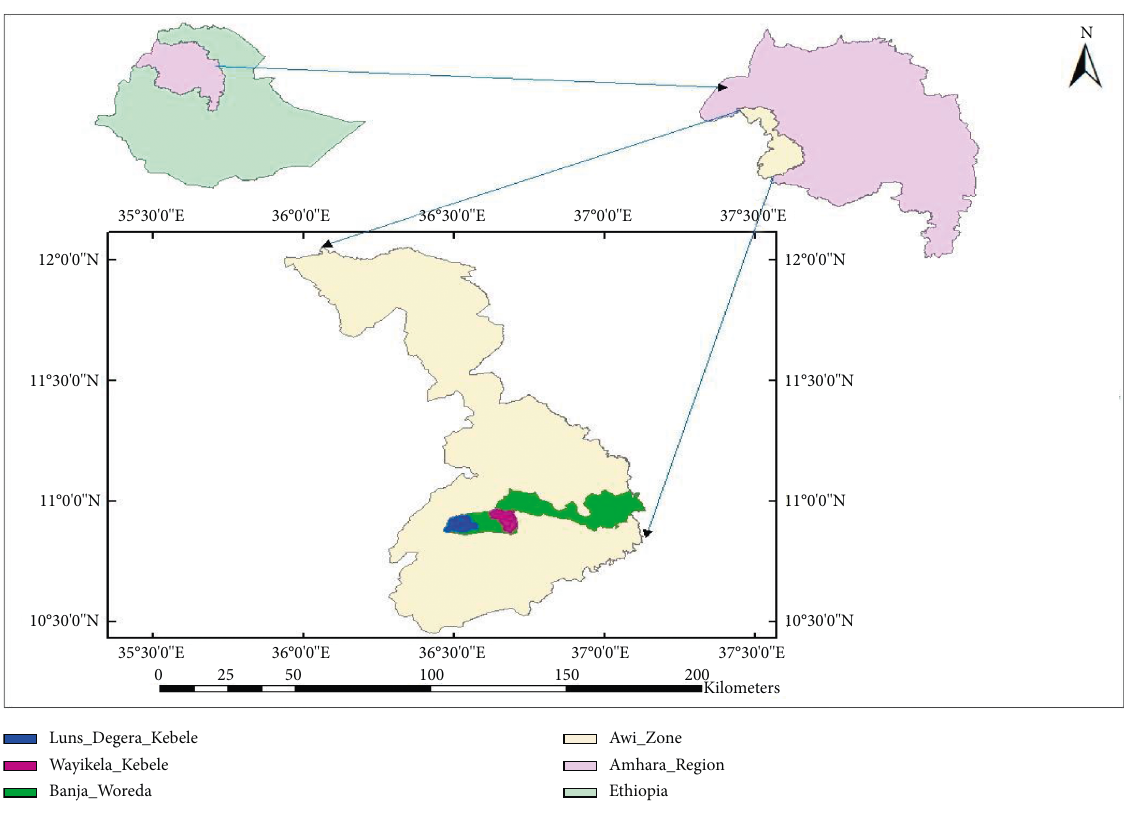
Figure 1: Map of the study